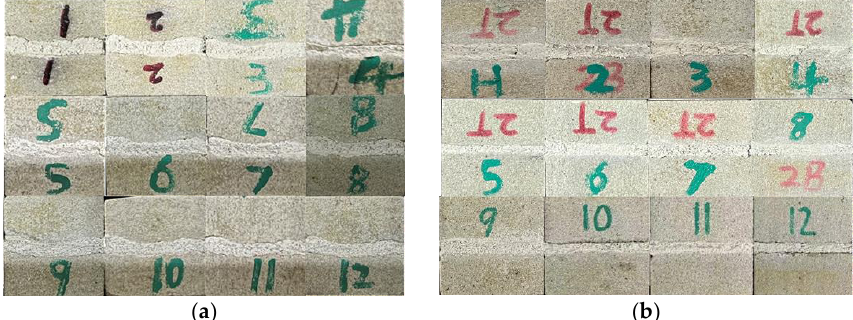
Figure 9. The completed direct shear experiment sample. ( a ) is shear type experimental sample; ( b ) is a tensile type experimental sample.